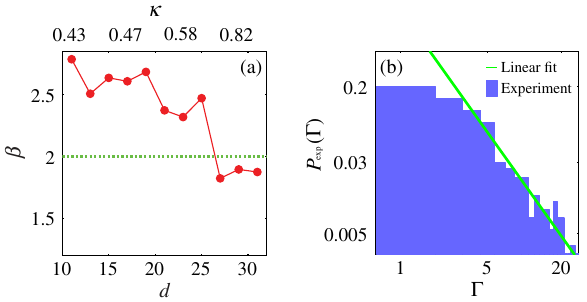
FIG. 5. (a) Power-law exponent β (markers) of the large Γ Γ Þ ∝ Γ − β at different d . The limiting value behavior of P exp ð β ¼ 2 is reported as a dashed line. (b) Comparison between Γ Þ for d ¼ 29 (solid curve) and power-law experimental P exp ð distribution Γ − 2 (solid